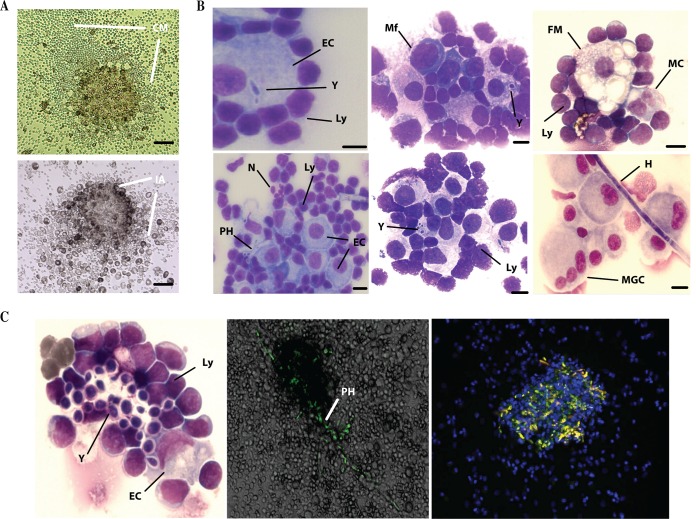
Histological examination of immune infiltrates induced by Candida spp. (A) Light microscopy observation of immune infiltrates and cell migration gradients (CM) 6 days postinfection. Cells were washed twice in PBS, and remaining compact inflammatory aggregates (IA) were analyzed. Scale bar: 50 μm. (B) May-Grünwald-Giemsa staining of immune aggregates 6 days after infection. Y, yeasts; PH, pseudohypha; H, hypha; Mf, activated macrophages; EC, large activated macrophages; MC, multinucleated cells with two nuclei; FM, foamy macrophages; MGC, multinucleated giant cells; N, neutrophils; Ly, lymphoid cells. Bars represent 20 μm. (C) Time-lapse and confocal microscopy examination of granuloma-like structures. Human immune cells were incubated with GFP-tagged C. albicans under the same coculture conditions as described in the text. Nuclear DNA was stained with Hoechst. Fluorescence-stained sections were examined under a Nikon A1 RSI microscope at a magnification of ×20 and constant Z-steps, and 3D images were processed with NIS elements version 3.21 and Volocity 3D image analysis software version 6.01.